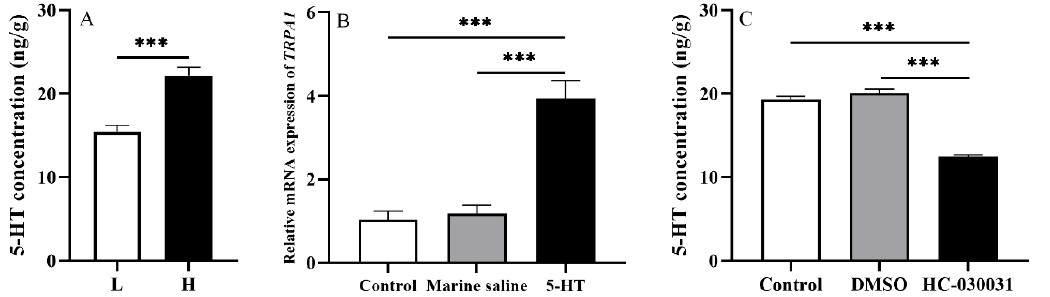
Figure 4. An inter-regulatory relationship between TRPA1 and 5-HT in the gut of Strongylocentrotus intermedius . ( A ) The 5-HT level in the gut of groups L and H ( n = 5). ( B ) TRPA1 expression after the 5-HT injection ( n = 5). ( C ) The 5-HT level after the HC-030031 injection ( n = 5). The symbol *** means p < 0.001, (mean ± s.e.m.).